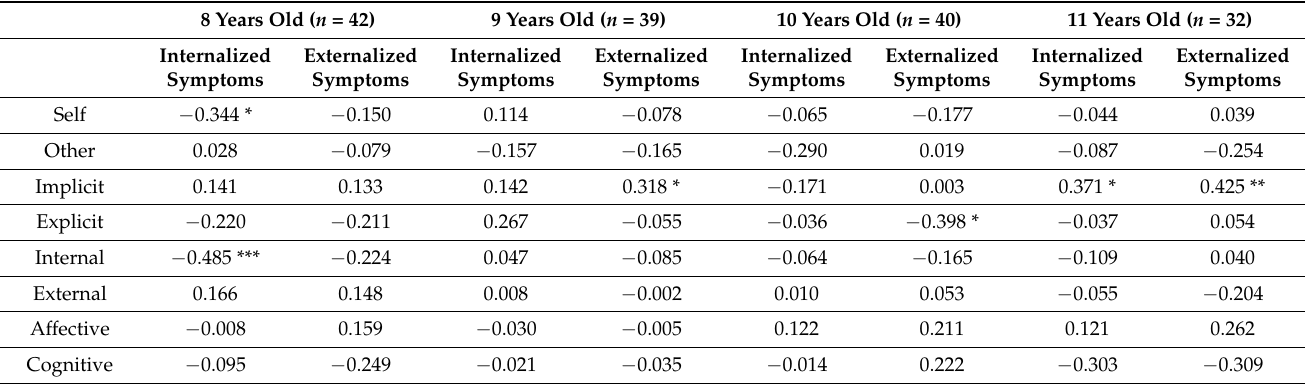
Table 7. Pearson correlation between CRF dimensions with Internalized and externalized psy- chopathology symptoms in four age